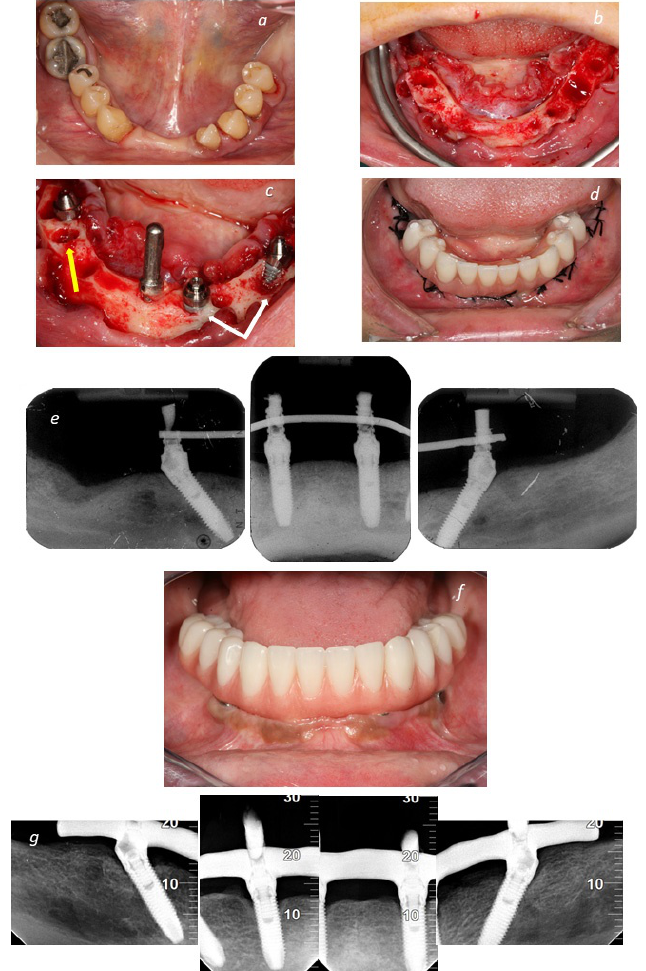
Figure 3. Clinical and radiographical displays illustrations of patients included in the study: ( a ) pre- treatment intraoral occlusal view of the mandible; ( b ) perioperative occlusal view following tooth extraction; ( c ) perioperative clinical photograph illustrating the implants. Note the dehiscence in the two implants of the third quadrant (anterior axial implant and posterior tilted implant on the right pointed by the white arrows) and the fenestration on the implant of the fourth quadrant (posterior tilted implant on the left pointed by the yellow arrow); ( d ) prosthesis connected on the same day of surgery achieving immediate function; ( e ) baseline periapical radiographs of the same patient; ( f) clinical photograph illustrating the 10 year follow-up of the same patient; ( g ) 10-year periapical radiographs of the same patient.